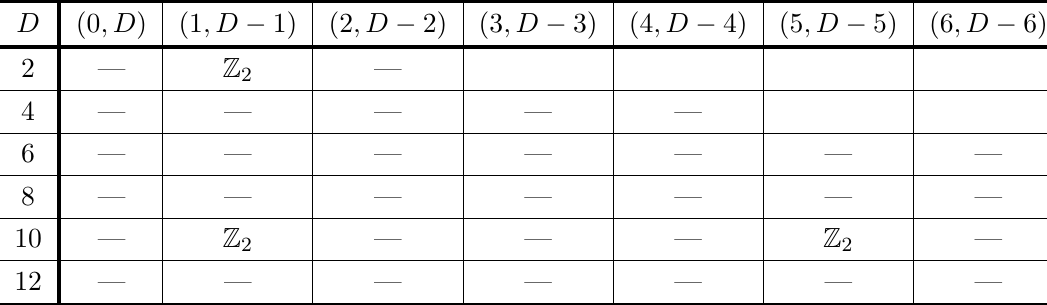
real supercharges, where d = dim S ). Where 2 S C . A dash 2